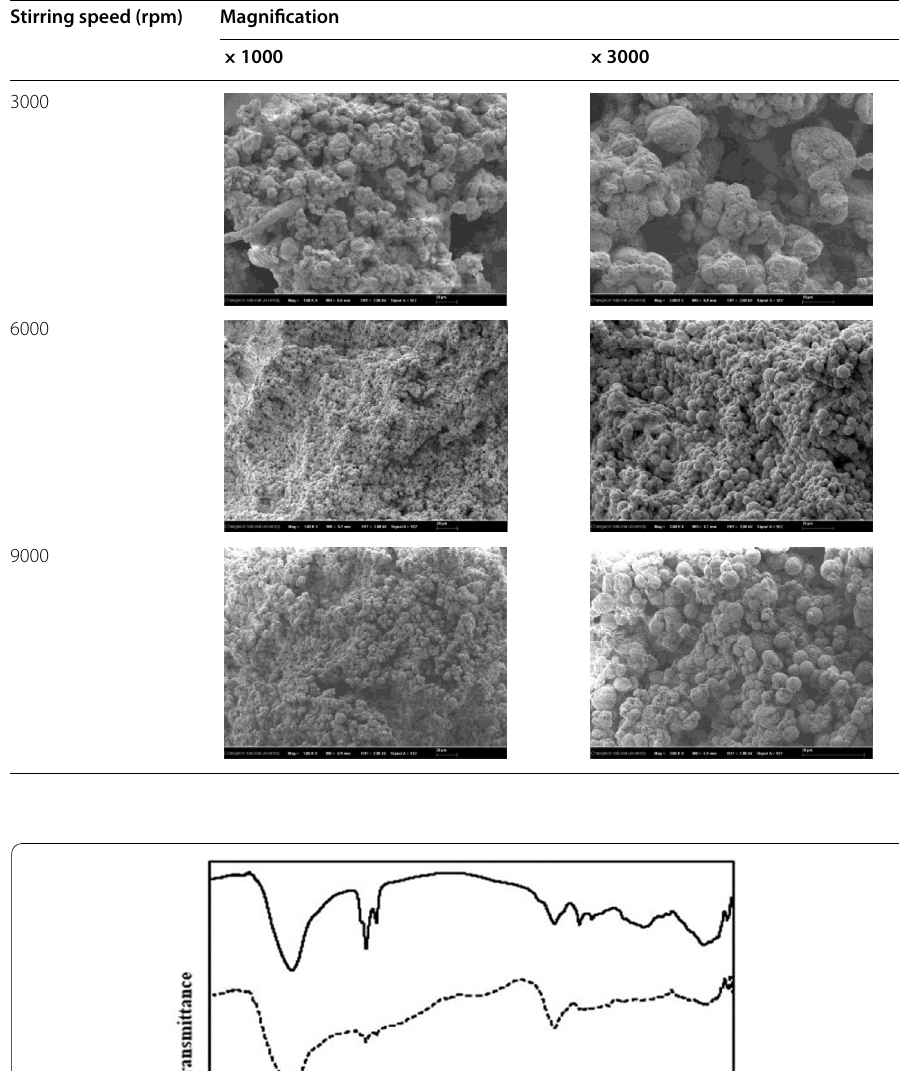
Table 3 Microscope images of microcapsules according to stirring speed Stirring speed (rpm)